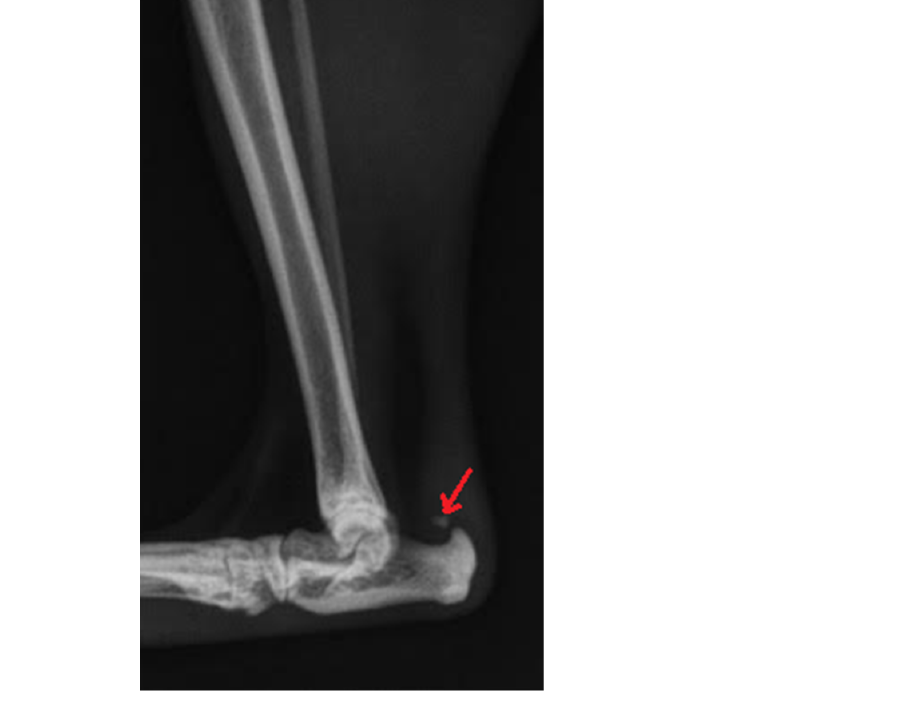
Figure 1. Radiographic image of total Achilles tendon rupture. The focus of tendon mineralization (arrow) is shown.